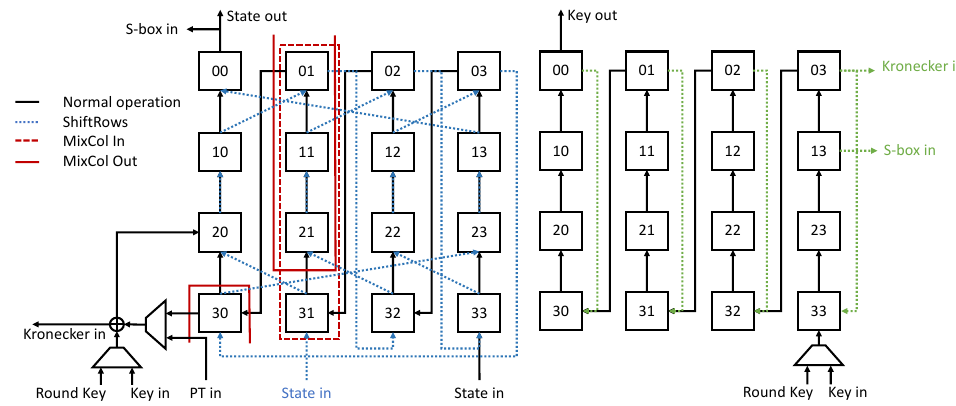
Figure 6: State and Key